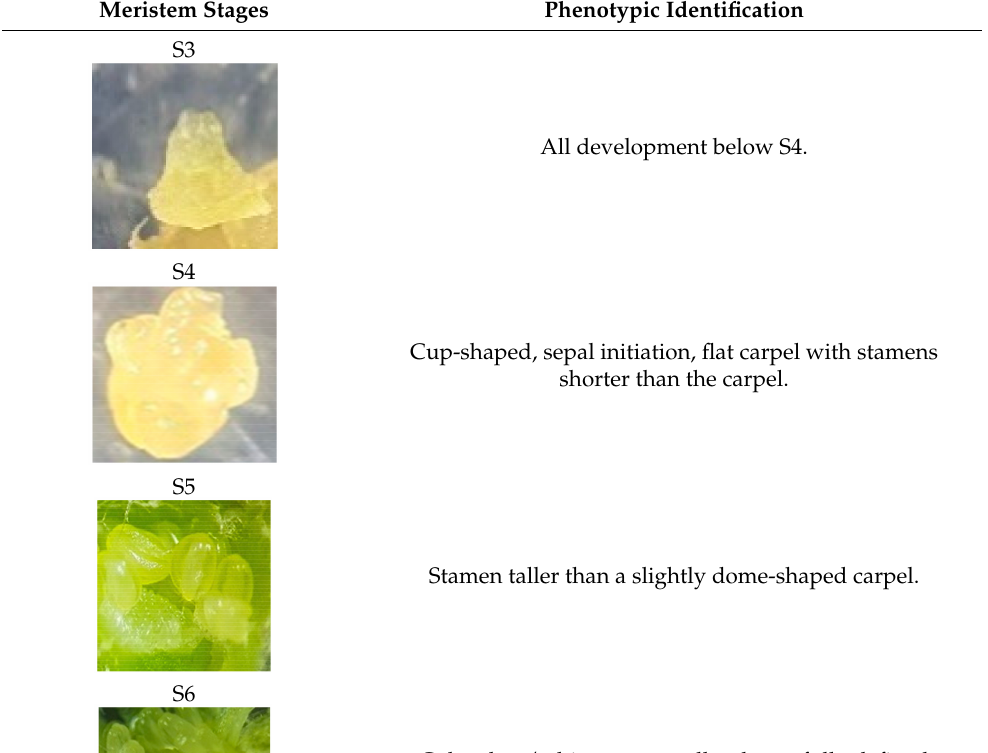
Table 2. Description of floral developmental stages (S3 to S9) for strawberry plants assessed under a stereo light microscope. Stages below S4 were regarded as vegetative, while stages from 4 to 9 were regarded as reproductive.